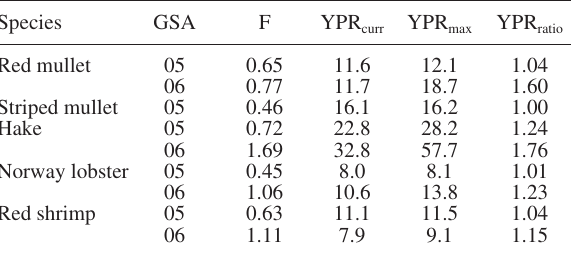
Table 2. – Status indicators of fishing exploitation (fishing mortal- ity, F; and yield per recruit, YPR) for the most important demersal target species in two GFCM geographical sub-areas (GSAs) from the western Mediterranean: GSA05 (Balearic Islands) and GSA06 (Northern Spain). For the YPR, the current (YPR ), maximum curr (YPR ) and its ratio (YPR =YPR /YPR ) are shown. See max ratio max curr Material and Methods and Annex 1 for details. Red mullet: Mul- lus barbatus ; striped red mullet: M. surmuletus ; hake: Merluccius merluccius ; Norway lobster: Nephrops norvegicus ; and red shrimp: Aristeus antennatus